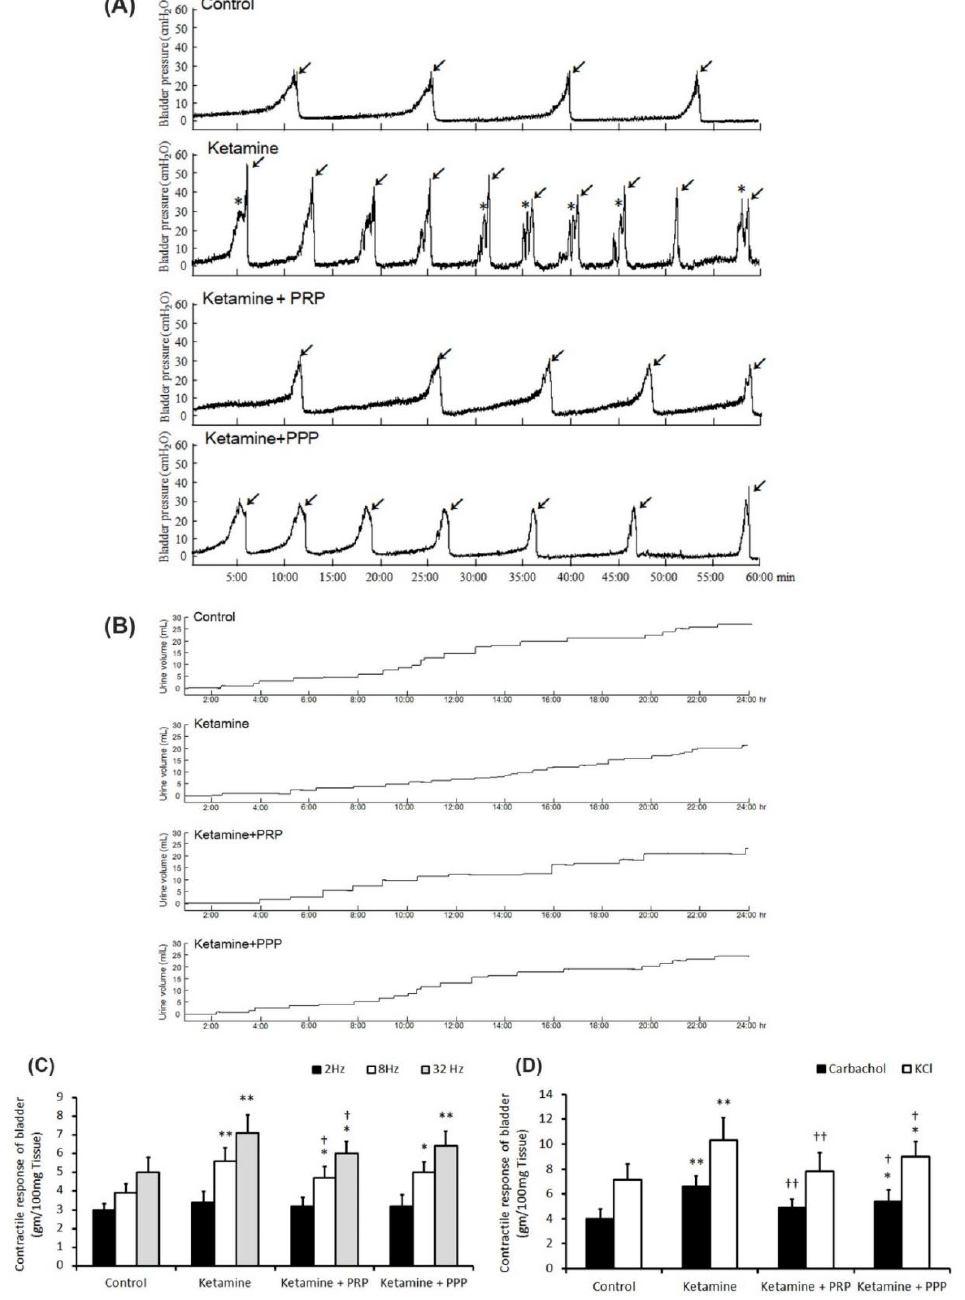
Figure 1. Cystometric parameter, voiding behavior and contractile responses. ( A ) Cystometric recordings performed for micturition pressure, voiding volume, and urinary frequency, including voiding contraction (arrows) and non-voiding contraction (asterisks). ( B ) Tracing analysis of void- ing behavior for 24 h by metabolic cage. The ketamine group exhibited significantly increases in bladder micturition pressure, voiding contractions, non-voiding contractions and micturition fre- quency, whereas PRP and PPP treatment meaningfully ameliorated bladder micturition pattern and capacity. ( C , D ) Contractile responses of bladder strips and statistics data were examined by electri- cal field stimulation (2 Hz, 8 Hz and 32 Hz) ( C ), carbachol ( D ) and KCl ( D ). Data were expressed as means ± SD for n = 4, * p < 0.05; ** p < 0.01 versus the control group; † p < 0.05; †† p < 0.01 versus the ketamine group.